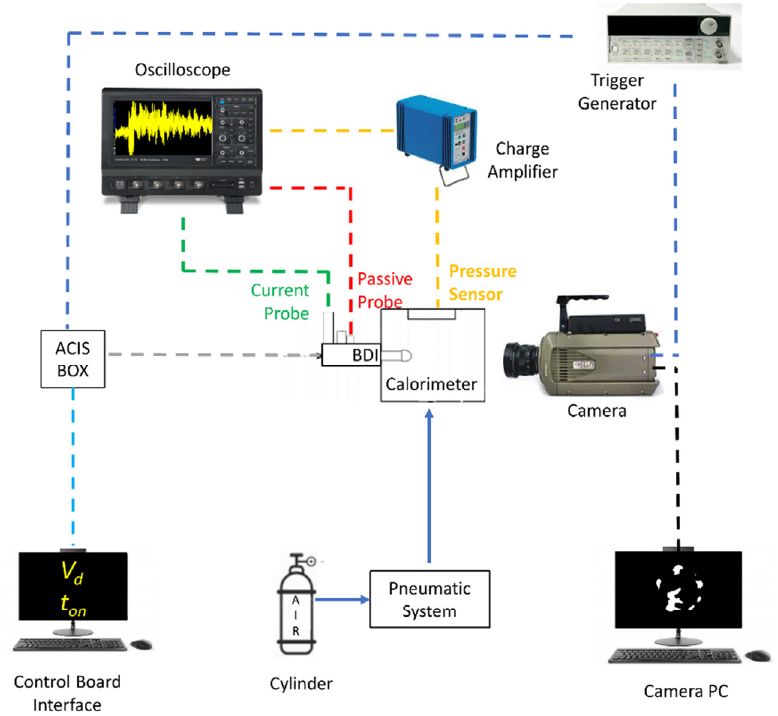
Figure 2. Experimental setup.